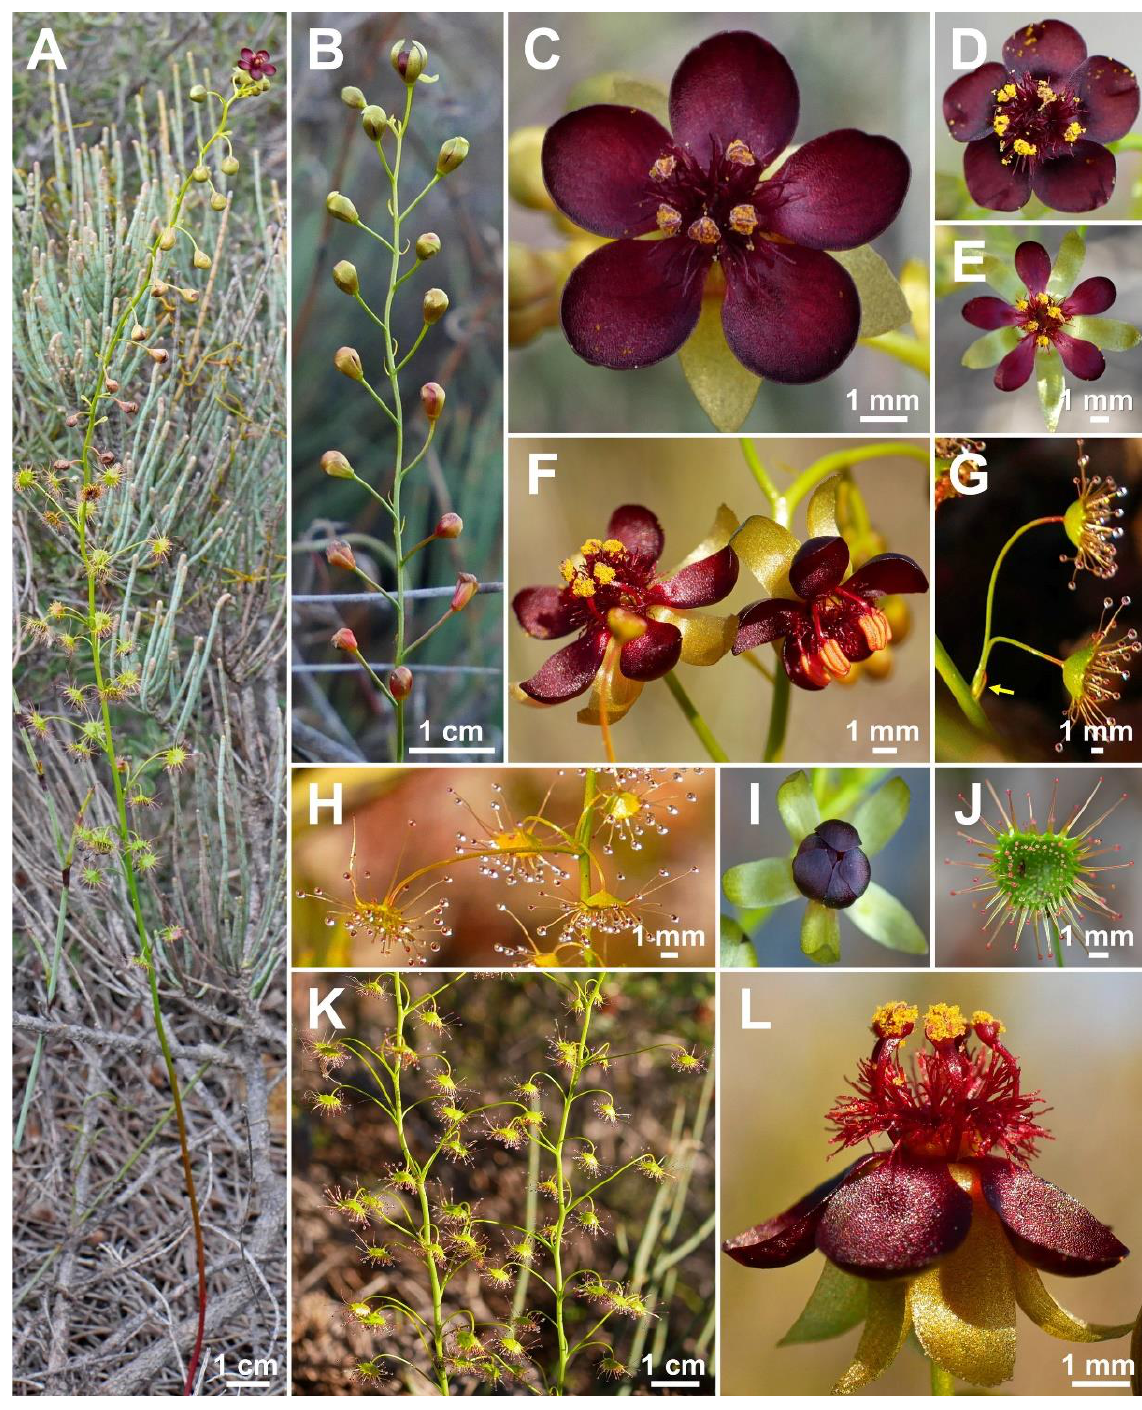
Figure 2. Drosera atrata T.Krueger, A.Fleischm. & G.Bourke. ( A ) habit; ( B ) inflorescence; ( C – E ) flowers in diffuse light; ( F ) flowers in bright sunlight, note that thecae of anthers are open to present the yellow pollen on the left flower, while in the younger flower at right they are still closed and orange; ( G ) cataphyll (yellow arrow) with two carnivorous axillary leaves; ( H ) cauline leaf with three smaller axillary leaves; ( I ) flower with closed petals in the late afternoon; ( J ) lamina; ( K ) two stems with cauline leaves, note groups of axillary leaves present throughout on all nodes and the downward-facing laminae; ( L ) flower in bright sunlight, lateral view. ( A , C – E , I , J ) from Coomallo Nature Reserve, Western Australia, 21 July 2019; ( B ) from near Warradarge, Western Australia, 25 June 2021; ( F , K ) from east of Warradarge, Western Australia, 22 May 2022; ( G , H , L ) from Badgingarra, Western Australia, 25 June 2022. Images: T. Krueger.